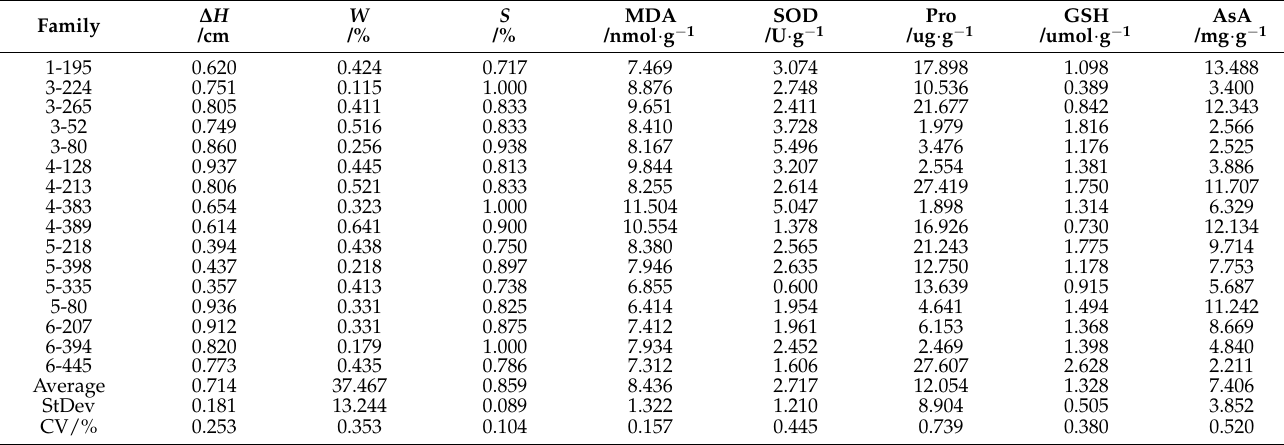
Table 4. DC of each index of the tested